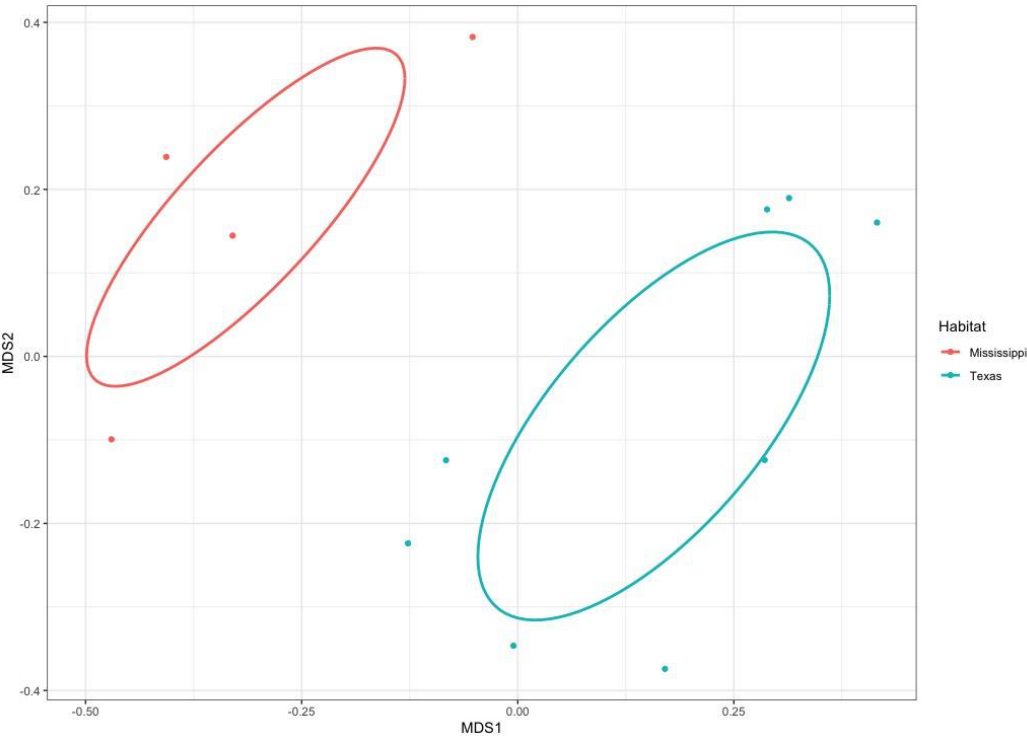
Figure 4. Non-metric multidimensional scaling (nMDS) of Bray–Curtis similarity data performed on total abundance by genera. Individual points are a representation of a collection location in a given year.